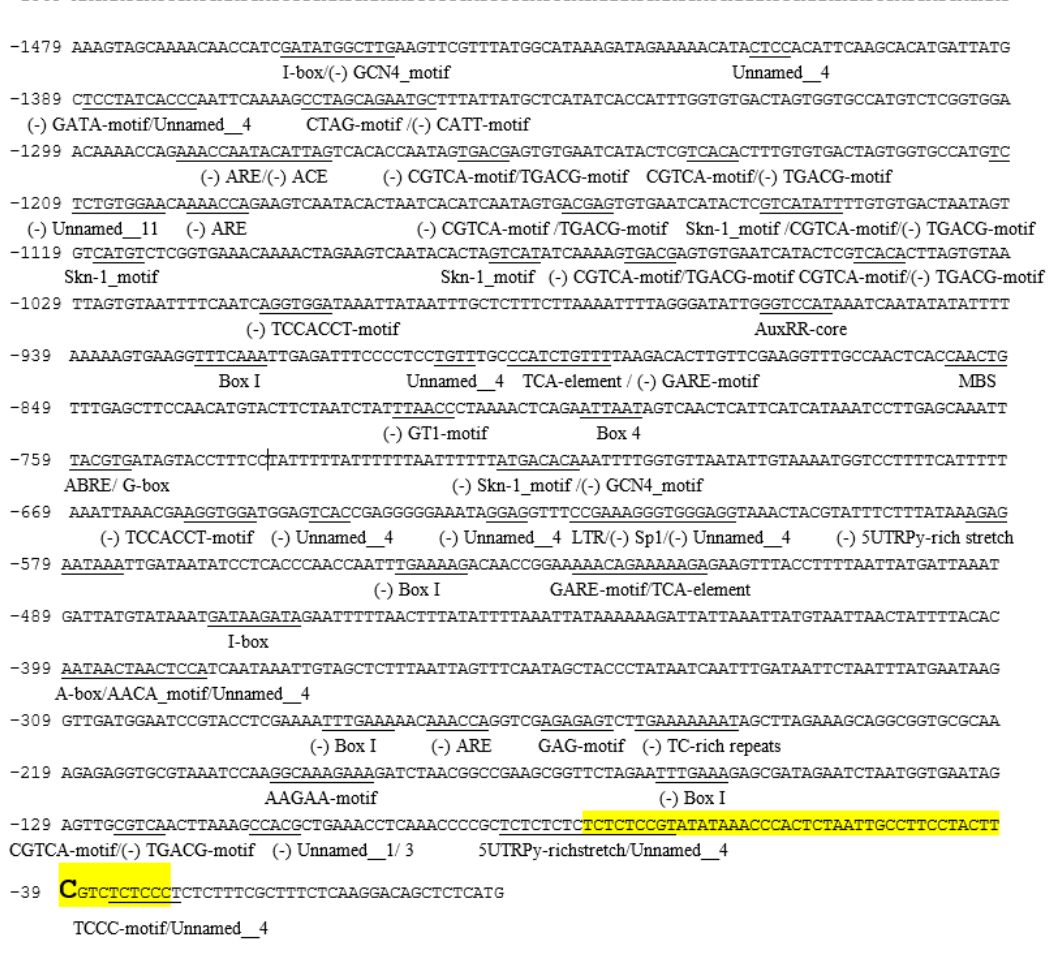
Figure 4. The sequence and structure analysis of the promoter of DlRan3B. The translation initiation site is ATG, the core promoter region is highlighted in yellow, and the transcription start sites (TSS) is highlighted in large bold letters.